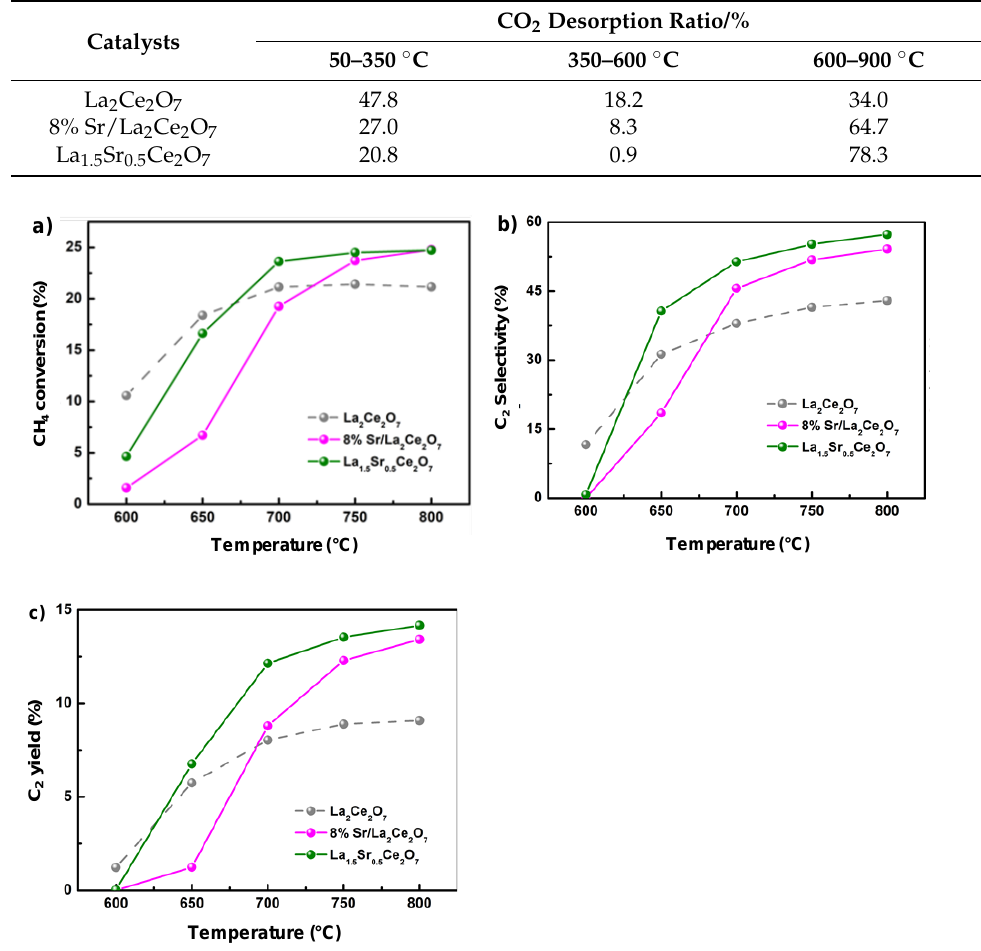
Figure 11. OCM reaction over the indicated catalysts: ( a ) CH 4 conversion, ( b ) C 2 selectivity, ( c ) C 2 yield. Reaction condition: CH 4 :O 2 :N 2 = 4:1:5, WHSV = 72,000 mL·g −1 ·h −1 [89] .